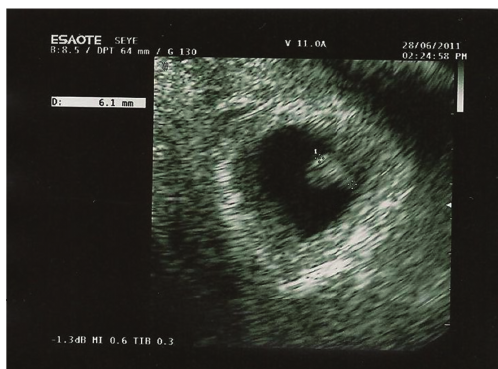
Figure 1: Transvaginal ultrasound of uterus showing a gestational sac of approximately 7 weeks.